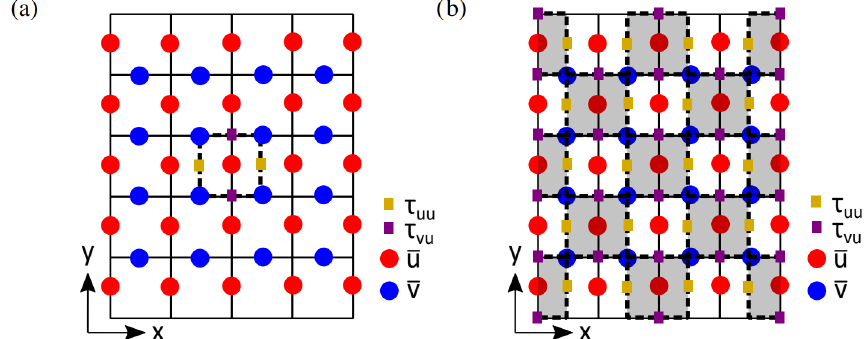
Figure 4. (a) Example two-dimensional input stencil of u,v that the ANN corresponding to the control volume of u receives, together with four of its outputs (i.e. τ in uu , τ out uu , τ in uv , τ out uv ). (b) Two-dimensional visualization of the way we evaluated the ANN during a posteriori simulations. By evaluating the ANN in checkerboard-like pattern (i.e. only evaluating the grey-shaded grid cells) and making use of the periodic boundary conditions, we could calculate all needed correction terms except those close to the